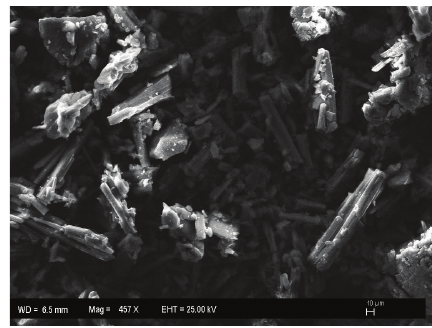
Figure 3: The SEM micrograph of